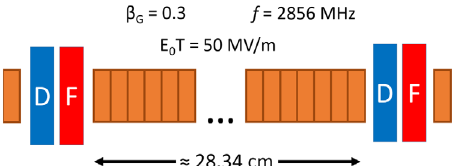
FIG. 4. Schematics of the accelerator scheme with the focusing lattice.